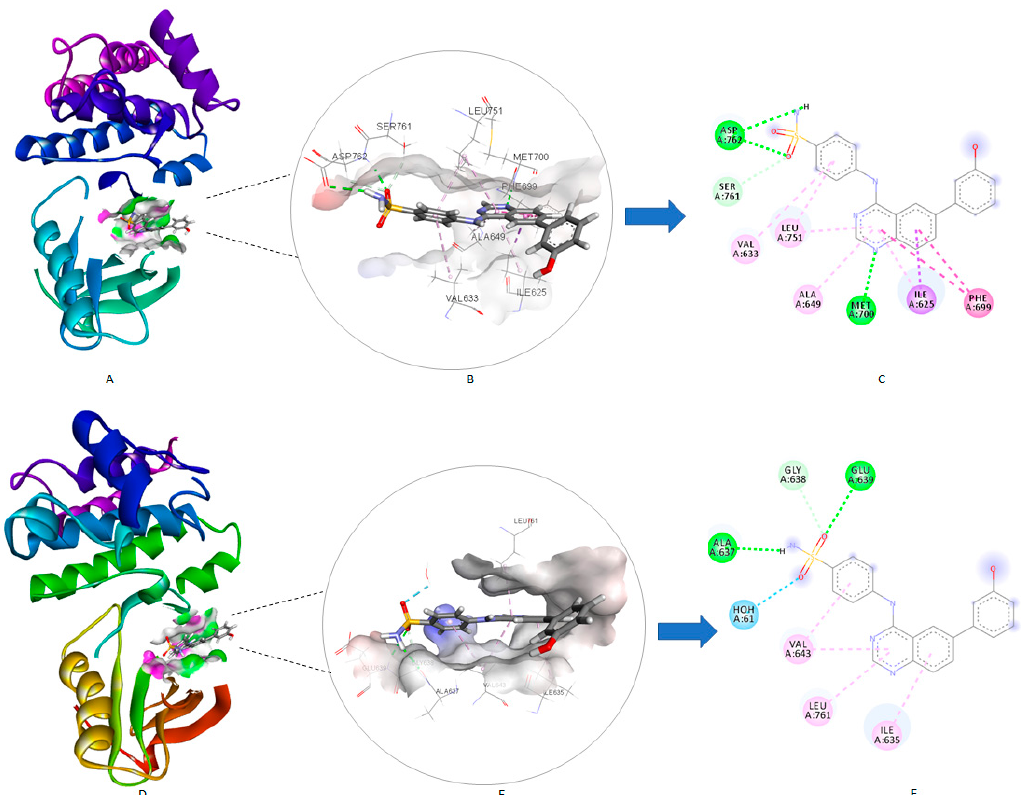
Figure 7. Docked complexes of compounds 4c with EphB1 and EphB2 isoforms: ( A ) 3D model of the crystal structure of EphB1 with the compound 4c ; ( B ) 3D docking model of compound 4c into EphB1 binding pocket; ( C ) 2D interaction diagram of compound 4c with EphB1 active site; ( D ) 3D model of the crystal structure of EphB2 with compound 4c ; ( E ) 3D docking model of compound 4c into EphB2 binding pocket; ( F ) 2D interaction diagram of compound 4c with EphB2 active site.